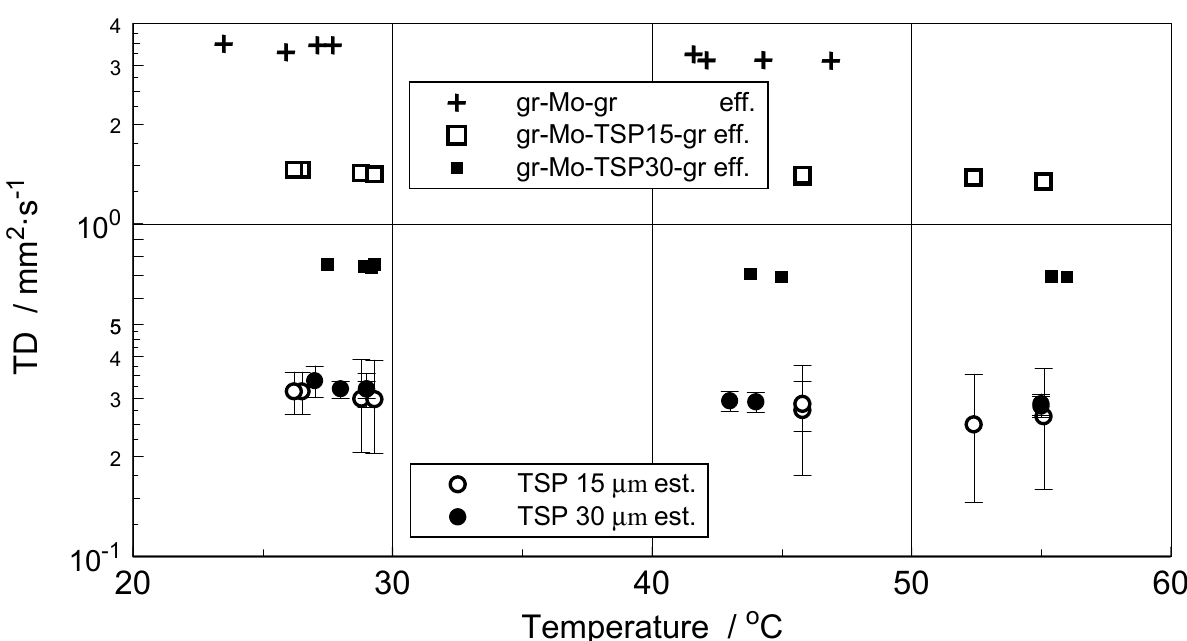
Figure 8. Apparent thermal diffusivity (TD) of the investigated composite GRAPHIT33–molybdenum–TSP–GRAPHIT33 specimens.